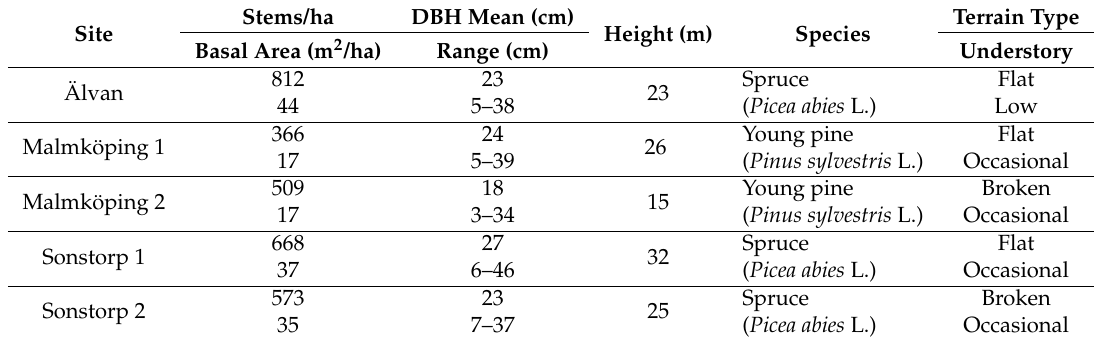
Table 1. Summary of the test